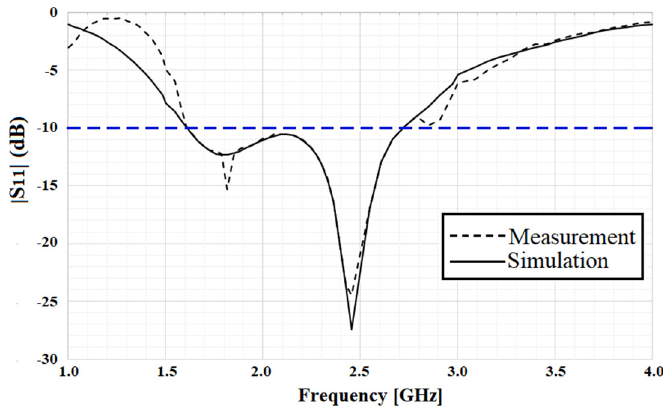
Figure 13. Simulated and measured reflection coefficient of the proposed antenna.